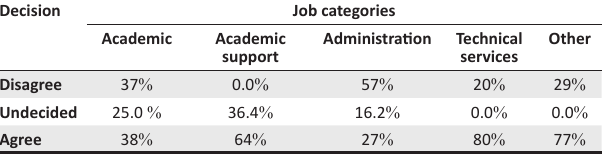
TABLE 2a: Cross-tabulations between ‘at my university rewards for acceptable performance are encouraged’ and job categories. Decision